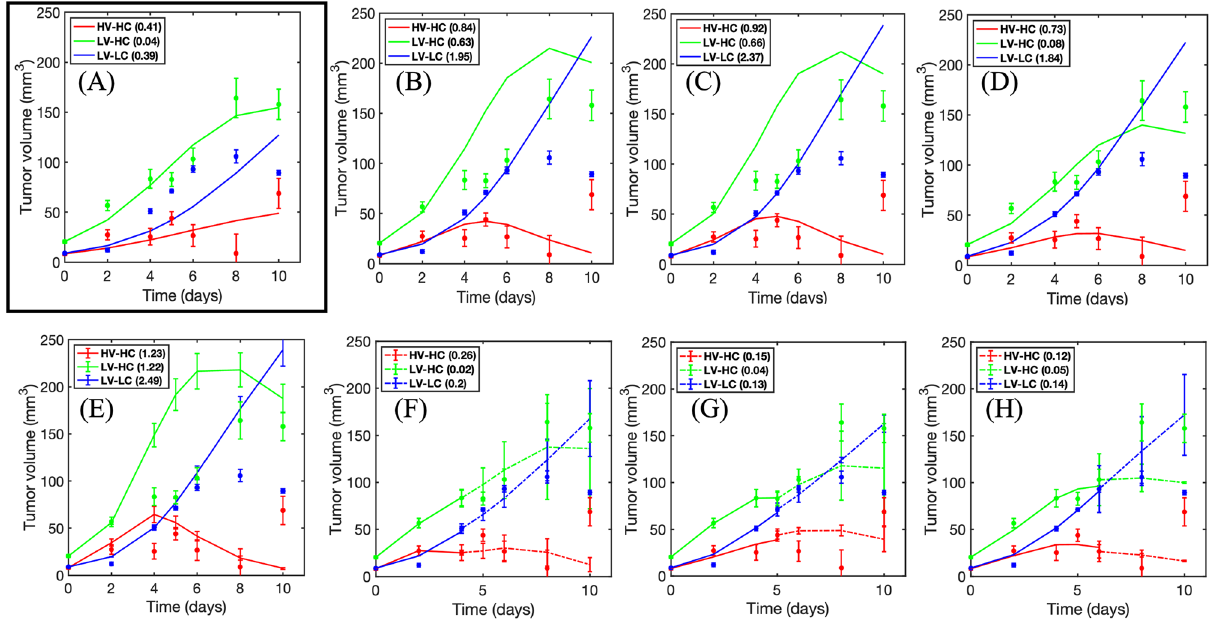
Figure 6. Predictions for a representative rat using the leave-one-out and bootstrapping approaches. ( A ) Model D calibrated to the habitat time series of a representative rat. The SSEs for each habitat are displayed